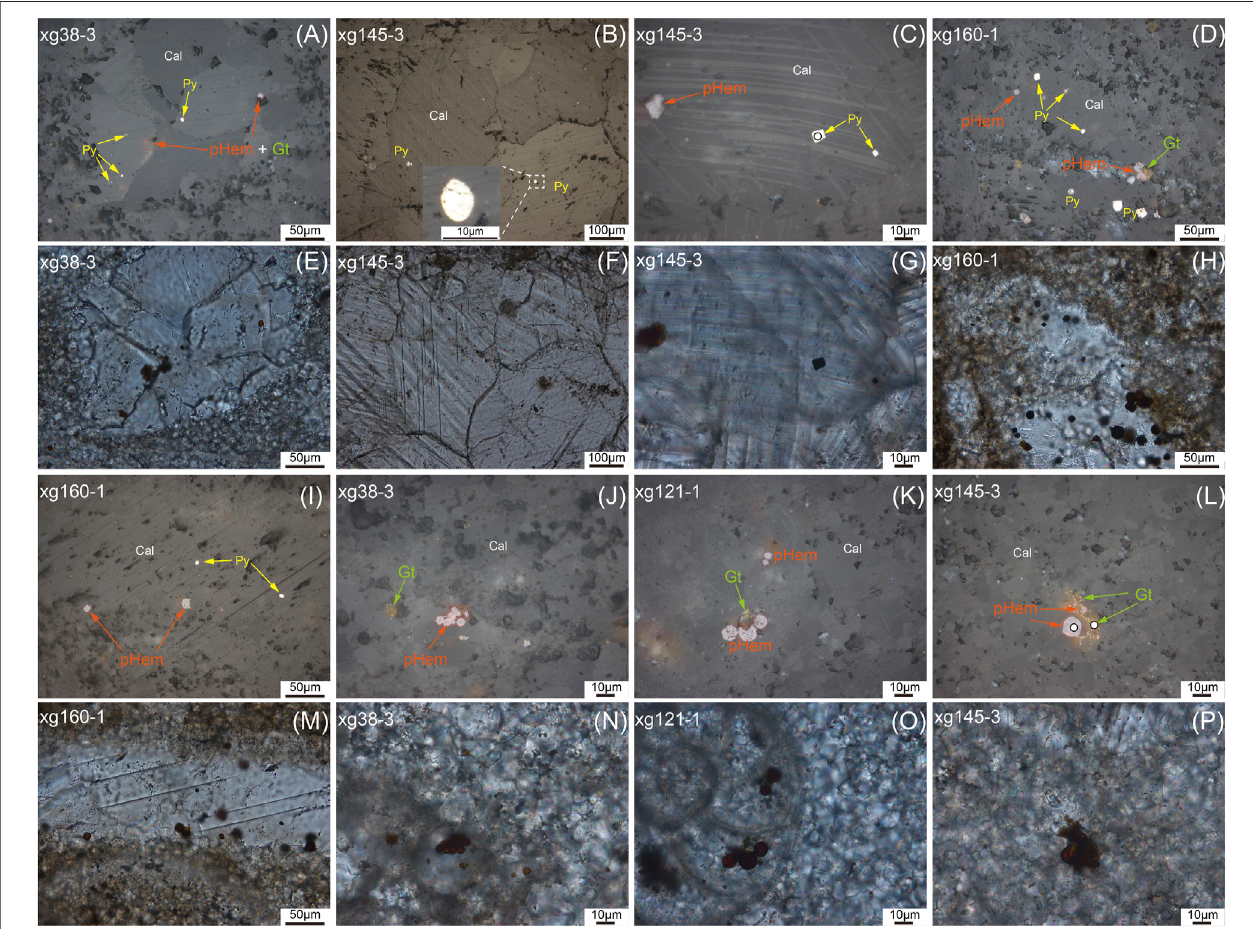
FIGURE 2 | Photomicrographs illustrating the iron oxide mineralogical features of limestones from the Zongpu Formation in the Gamba area under re fl ected light (A – D,I – L) and plane-polarized light (E – H,M – P) images. White dots in (C,L) represent the spots of Raman spectroscopy analyses in Figure 3 . Cal (cid:1) calcite; Gt (cid:1) goethite; pHem (cid:1) pigmentary hematite; Py (cid:1) pyrite.